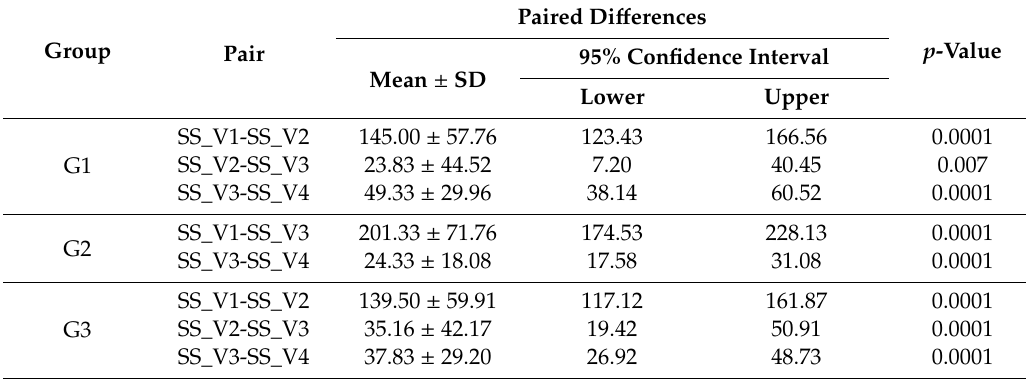
Table 3. IBS-SS comparisons for each group.